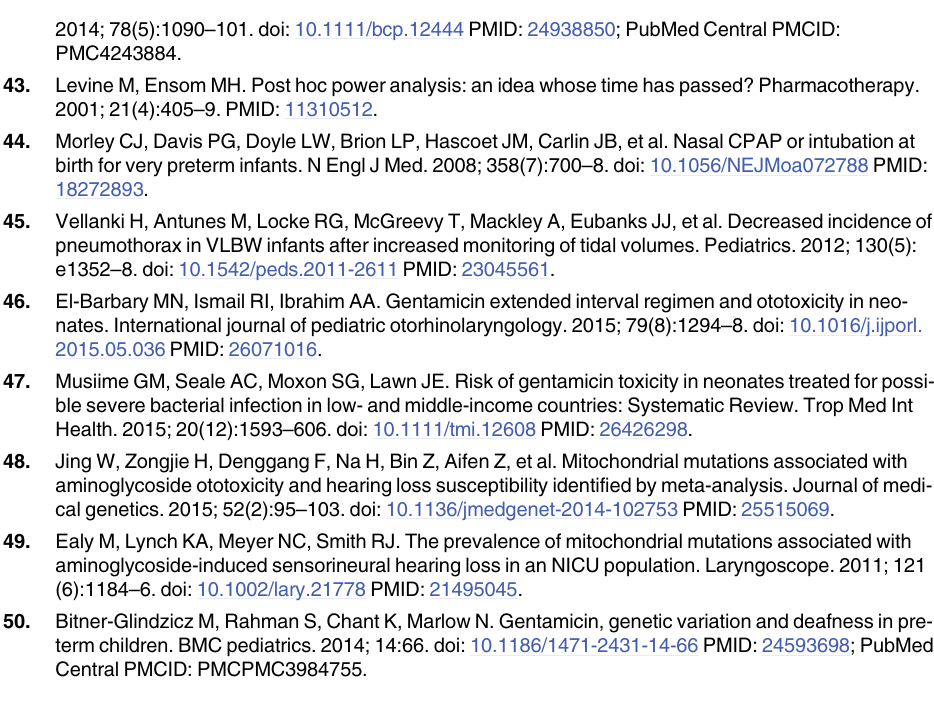
PLOS ONE | DOI:10.1371/journal.pone.0158806 July 8,